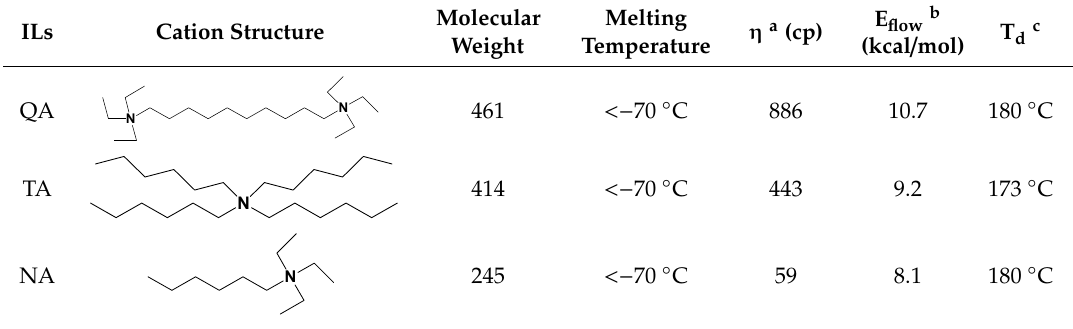
Table 1. Physical properties of quaternary ammonium-based room-temperature ionic liquids (QA RTILs).